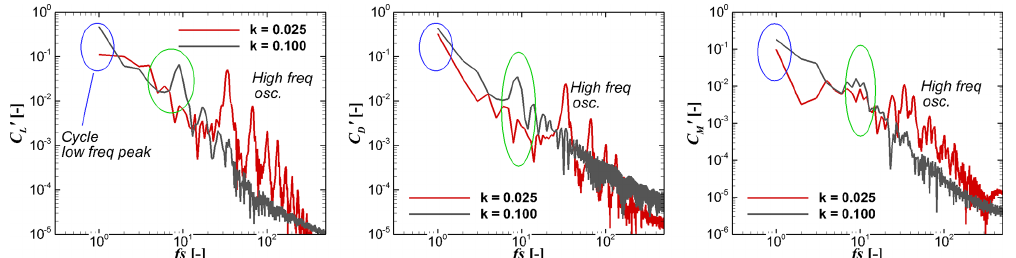
Figure 19. Fourier transformation of the predicted forces presented in Fig. 18. f s = f/f 0 with f 0 being the pitching frequency.